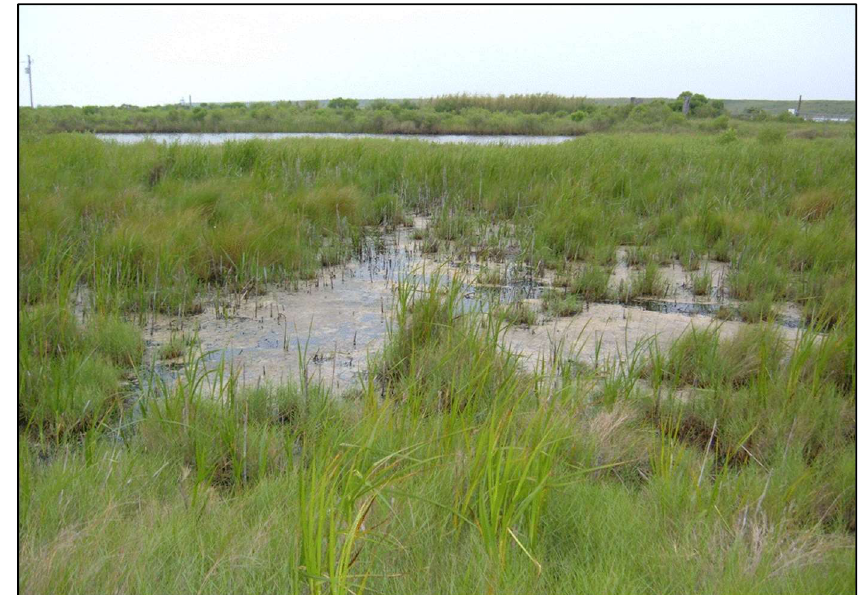
Figure 1. A saltwater marsh near Port Bolivar, Texas, where the infected Aedes sollicitans mosquitoes were collected. (Courtesy of Galveston County Mosquito Control.)